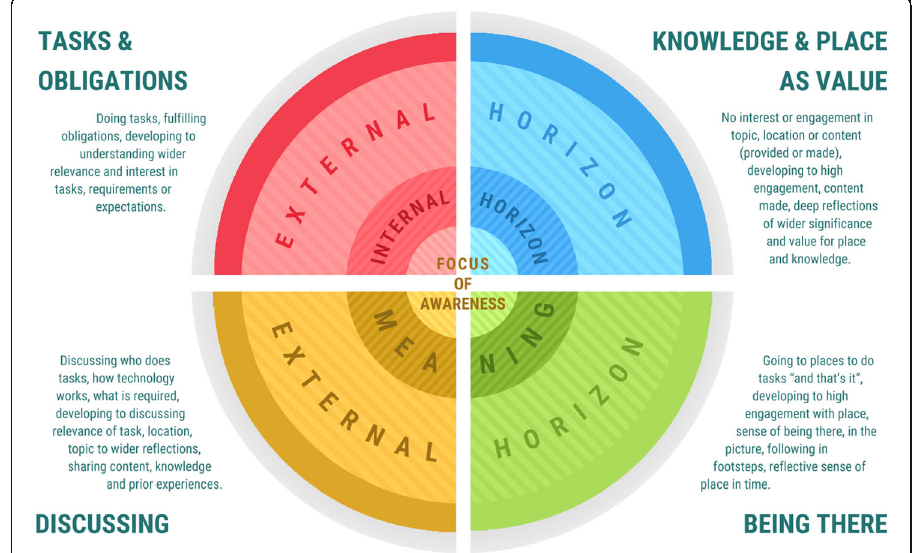
Fig. 1 Four categories of experience variation for the structure of awareness in a smart learning